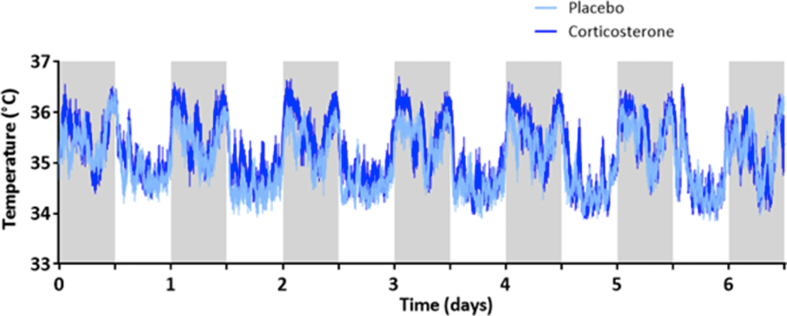
Flattening of corticosterone rhythm does not influence body temperature and activity in wild-type (WT) mice. Metabolic cage measurements to determine core body temperature in male WT mice implanted with placebo- and 2.5-mg corticosterone pellets.